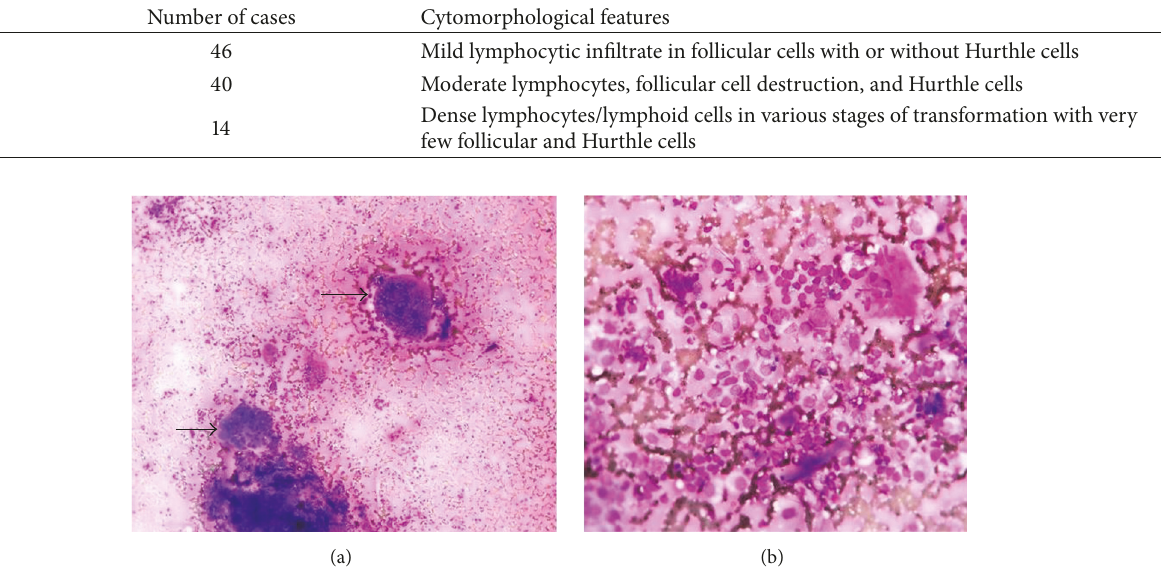
Figure 3: De Quervain’s thyroiditis: (a) smears showing follicular cell clusters with many giant cells (thick arrow, Leishman’s stain × 100); (b) epithelioid cells and lymphocytes (Leishman’s stain × 400).